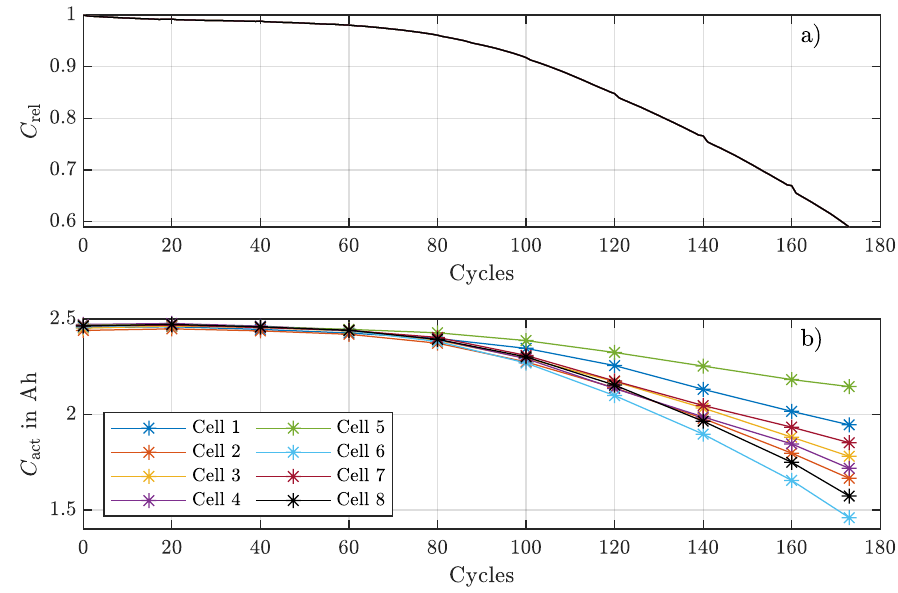
Figure 2. ( a ) Relative capacity of the module; ( b ) capacity values of all 8 cells obtained every 20